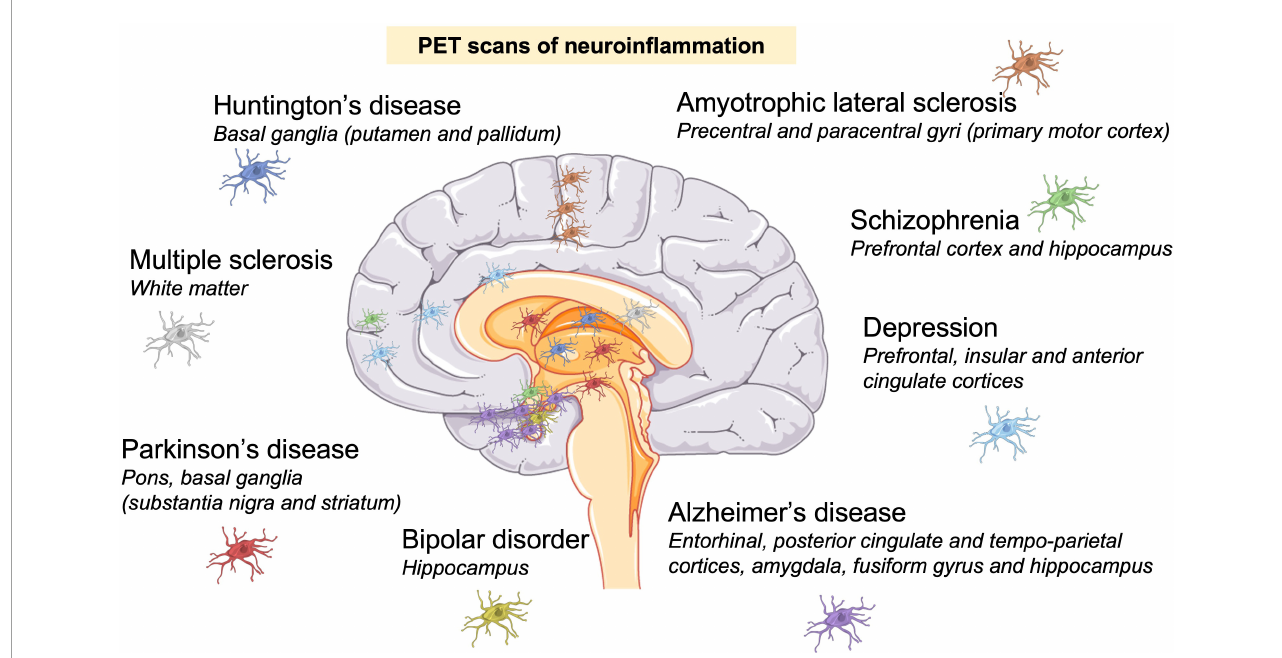
FIGURE3 Neuroinflammation is a hallmark of neurodegenerative and psychiatric disorders. Neuroinflammation was identified by positron emission tomography (PET) scans in patients. Presence of activated microglia (colored cells) in: Huntington’s disease (Lois et al., 2018); Parkinson’s disease (Gerhard et al., 2006); multiple sclerosis (Datta et al., 2017); amyotrophic lateral sclerosis (Alshikho et al., 2018); Alzheimer’s disease (Cagnin et al., 2007; Valotassiou et al., 2018); depression (Setiawan et al., 2015), schizophrenia (Doorduin et al., 2009; Marques et al., 2017); and bipolar disorder (Haarman et al.,